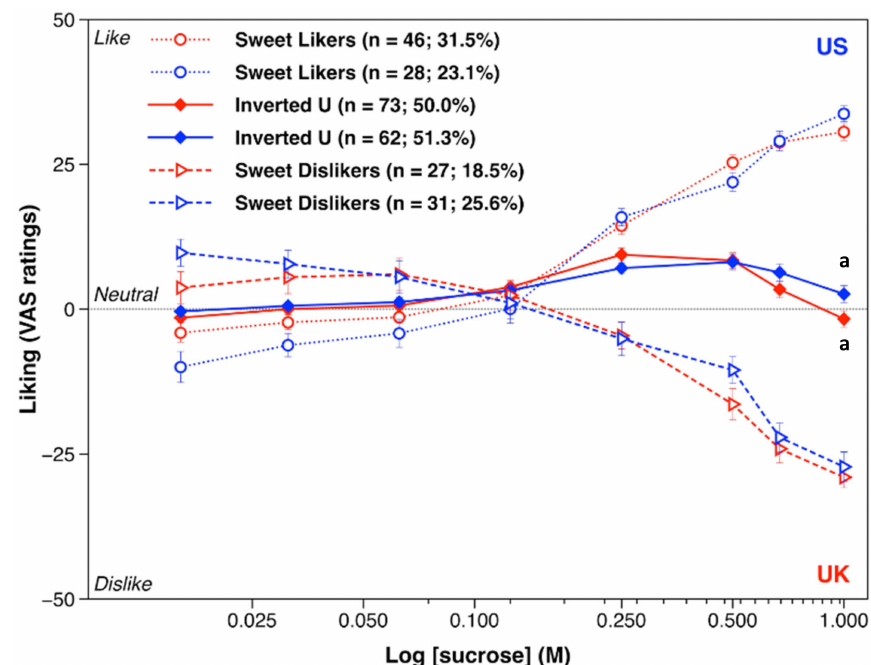
Figure 1. Liking ratings (mean ± standard error of the mean) as a function of sucrose solutions by the three sweet-liking phenotypes by cohort. Ratings were averaged across the two taste test blocks prior to clustering. Blue and red features represent ratings recorded in the US and the UK, respectively. The response pattern for the sweet-liking phenotype is displayed with a dotted line, the response pattern of the inverted U-shaped phenotype with a solid line, and the response pattern of the sweet disliker phenotype with a dashed line. Liking ratings within a sweet-liking phenotype that share a letter significantly di ff er.